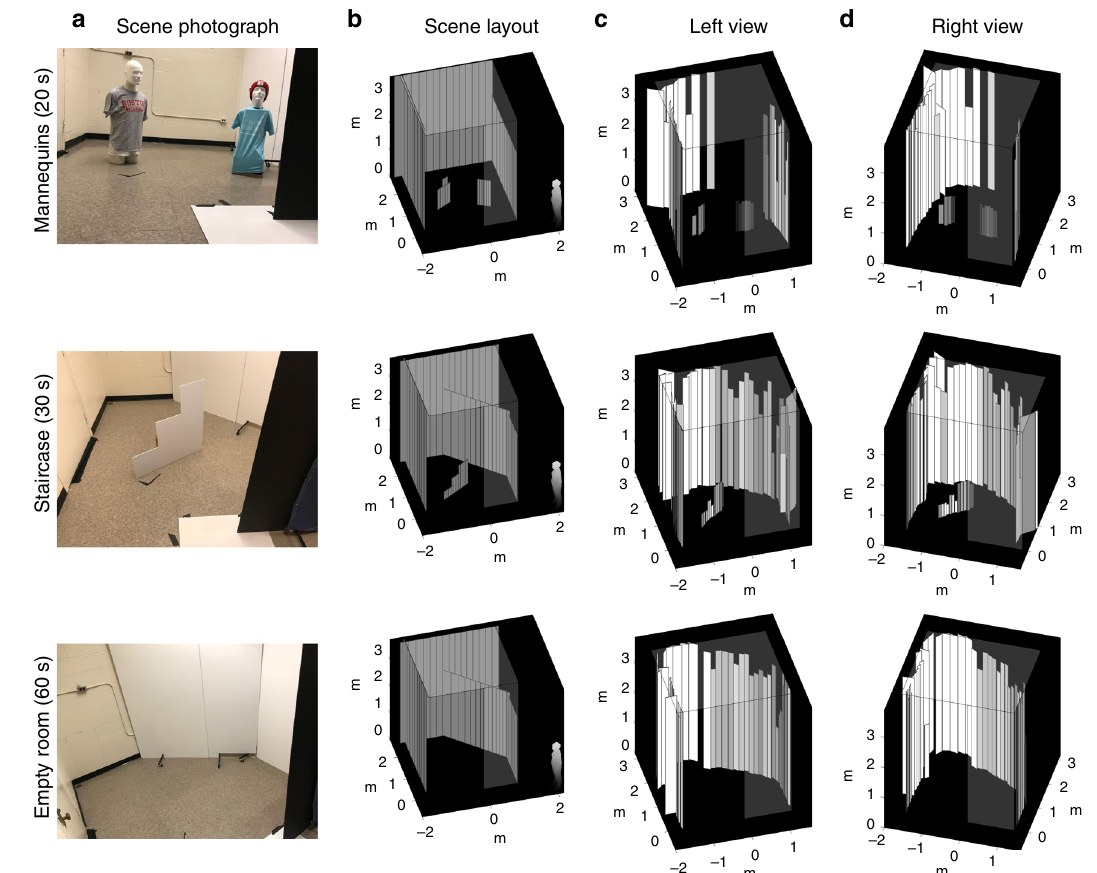
Fig. 5 ERTI reconstructions of hidden scenes. a Photographs show hidden rooms constructed from existing walls and foamcore panels. The rooms contain either two mannequins or a planar staircase or are empty. b Diagrams show the approximate layout of the hidden scene plus an observer at the position of the acquisition equipment. c Left & d right views of the reconstructed scenes, with the estimated ceiling height and known occluder edge shown partially transparent for context. Representative results are shown for different acquisition durations per illumination spot. Shorter acquisition times are suf fi cient for correctly localizing the foreground objects with height estimates within ≈ 10 cm, whereas longer times allow for more accurate estimation of distant facet heights and orientations. See Supplementary Note 6 for the effects of varying the acquisition time on the